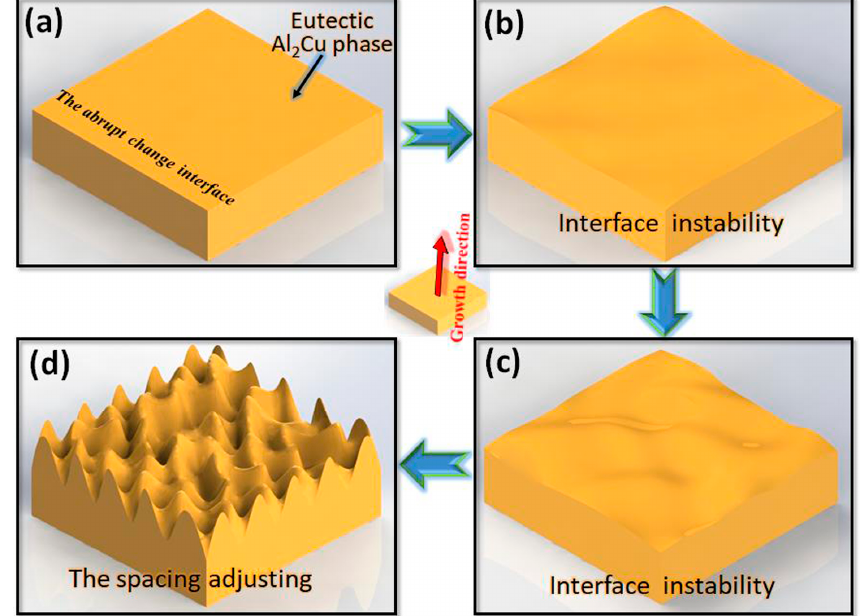
Figure 5. Schematic diagram of the Al-Al 2 Cu eutectic lamellar bifurcating and spacing adjustment: ( a ) Normal solidification rate, ( b ) lower solidification rate, ( c ) near the abruptly changing interface, and ( d ) higher solidification